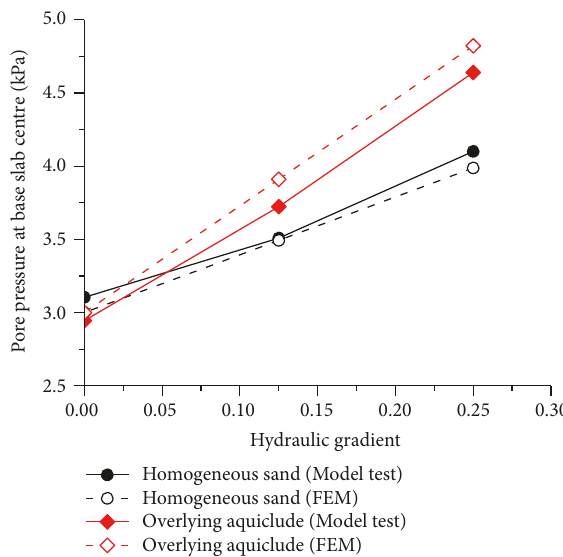
Figure 10: Comparison between measured pore pressure values and finite element results at base slab centre.